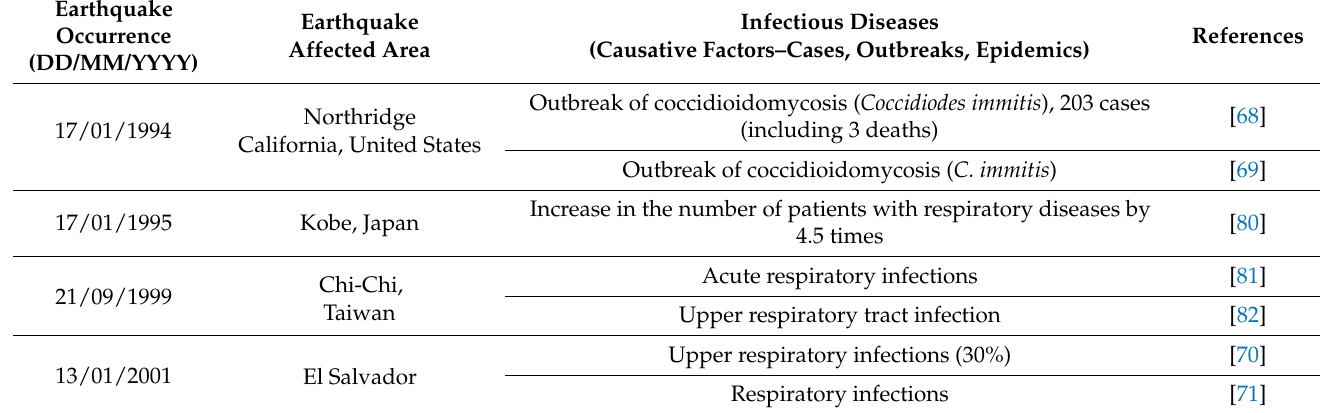
Table 2. Respiratory infectious diseases transmitted during the post-earthquake period in earthquake- affected